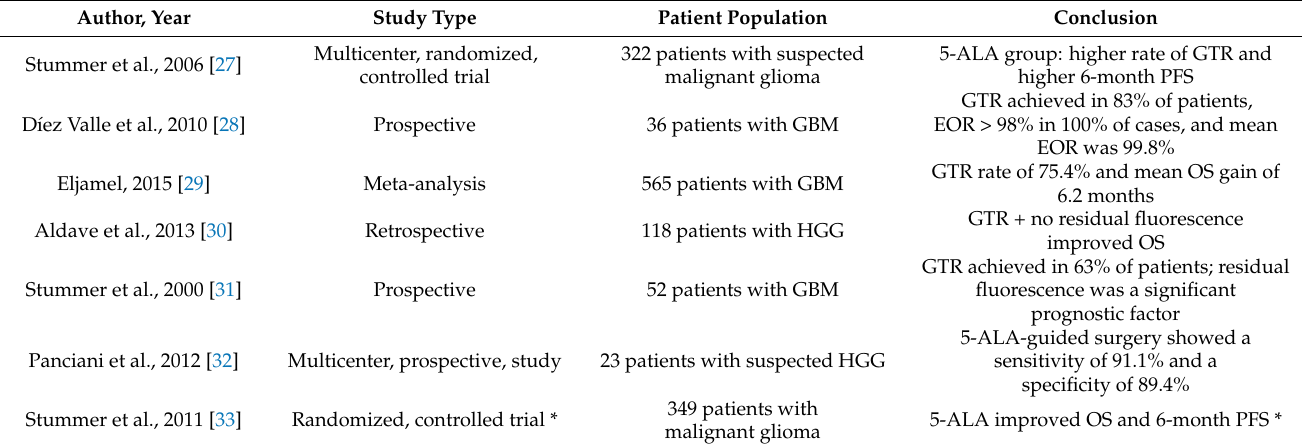
Table 2. Main studies evaluating the use of 5-ALA in patients with malignant